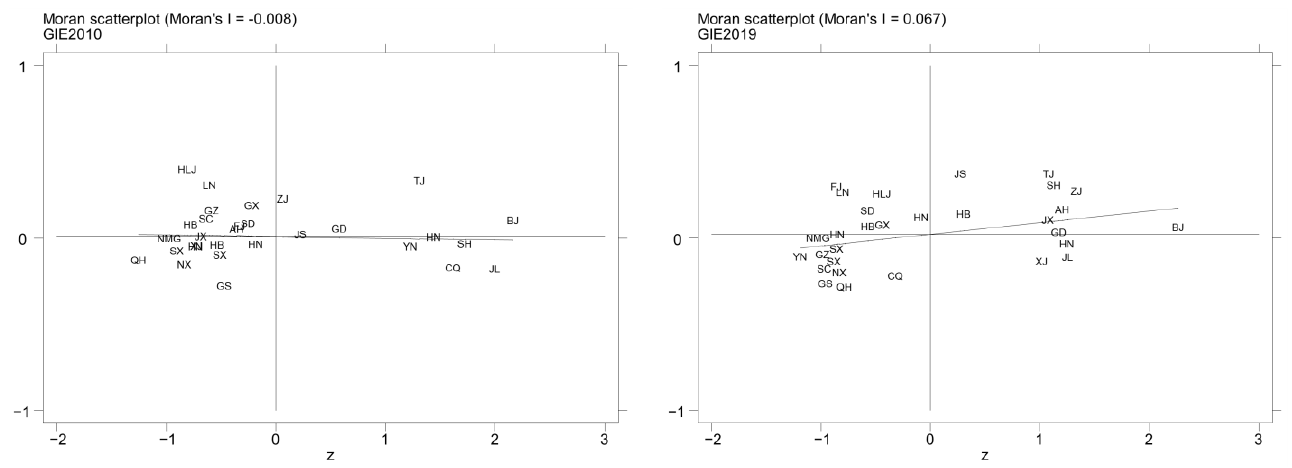
Figure 7. Local Moran’s I scatterplot of GIE of China in 2010 and 2019. With respect to MAGG, as presented in Figure 8, most provinces (autonomous regions and municipalities) are located in quadrants one and three, exhibiting spatial autocorrelation. The provinces (autonomous regions and municipalities) located in the first quadrant show a HH agglomeration, namely Shanghai, Zhejiang, Fujian, and Jiangsu. However, different from GIE, there are relatively fewer provinces (autonomous regions and municipalities) in the first quadrant in 2019, which conforms to the results of the MAGG level measurements. Nevertheless, China ’ s MAGG level still exhibits a strong lo- cal spatial agglomeration effect.